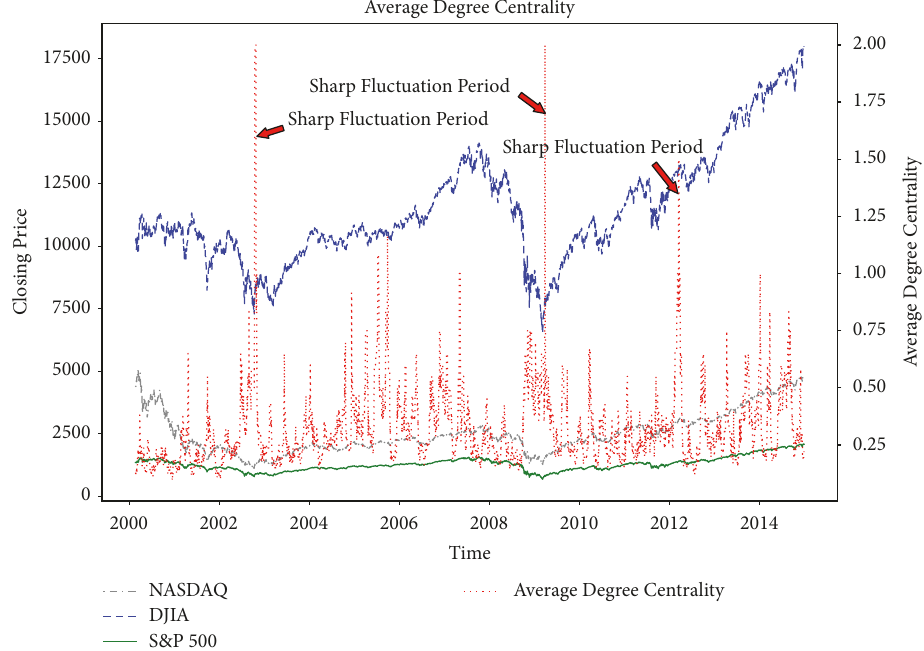
Figure 7: The evolution of the three stock indexes and average degree